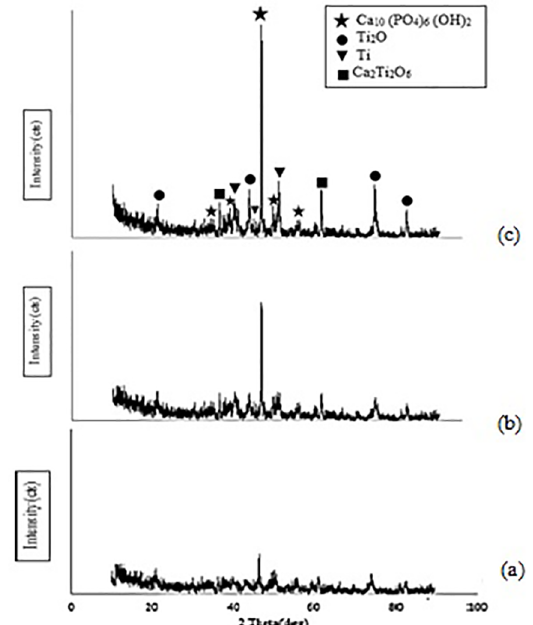
Figure 5. The XRD diffraction pattern of pressed samples under pressure of a) 300, b) 500 and c) 700 MPa and sintered in